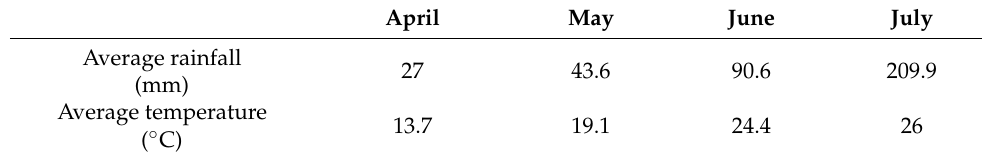
Table 1. Average monthly rainfall and temperature from April 2018 to July